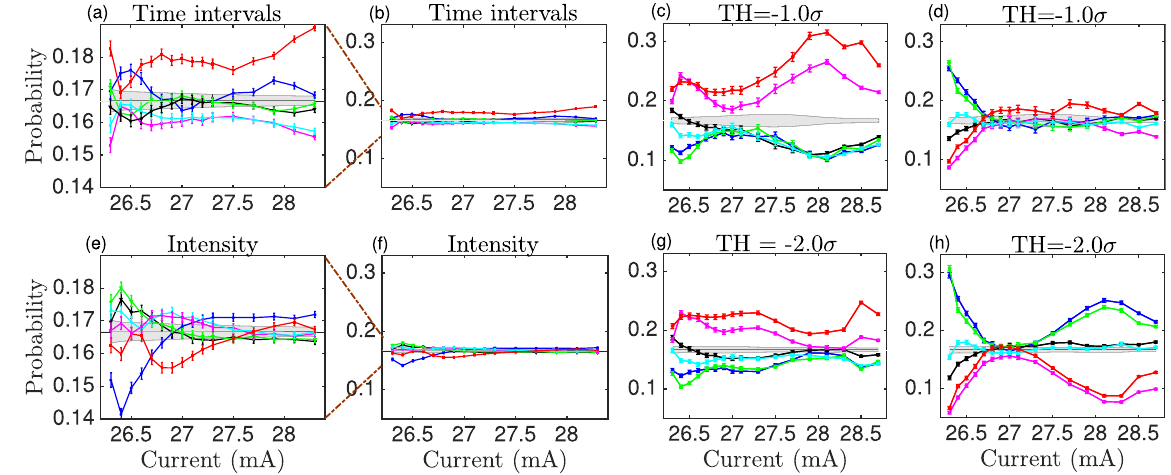
Figure 4. (a) Words probabilities computed with the time intervals between all the dropouts of the time series. (e) Words probabilities computed with the depths of all the dropouts of the time series. (c , d , g , h) Words probabilities that forecast the change in dynamics. (c , g) Forecast from a shallow event to a deep event. (d , h) Forecast from a deep event to a shallow event. Two different detection thresholds are shown, − 1.0 σ ( c , d ), and − 2.0 σ ( g , h ). (b , f) are the same plots as (a , e) but with the same vertical scale as the forecast plots. The probabilities of the forecast plots are considerably larger than those with the raw dropouts.